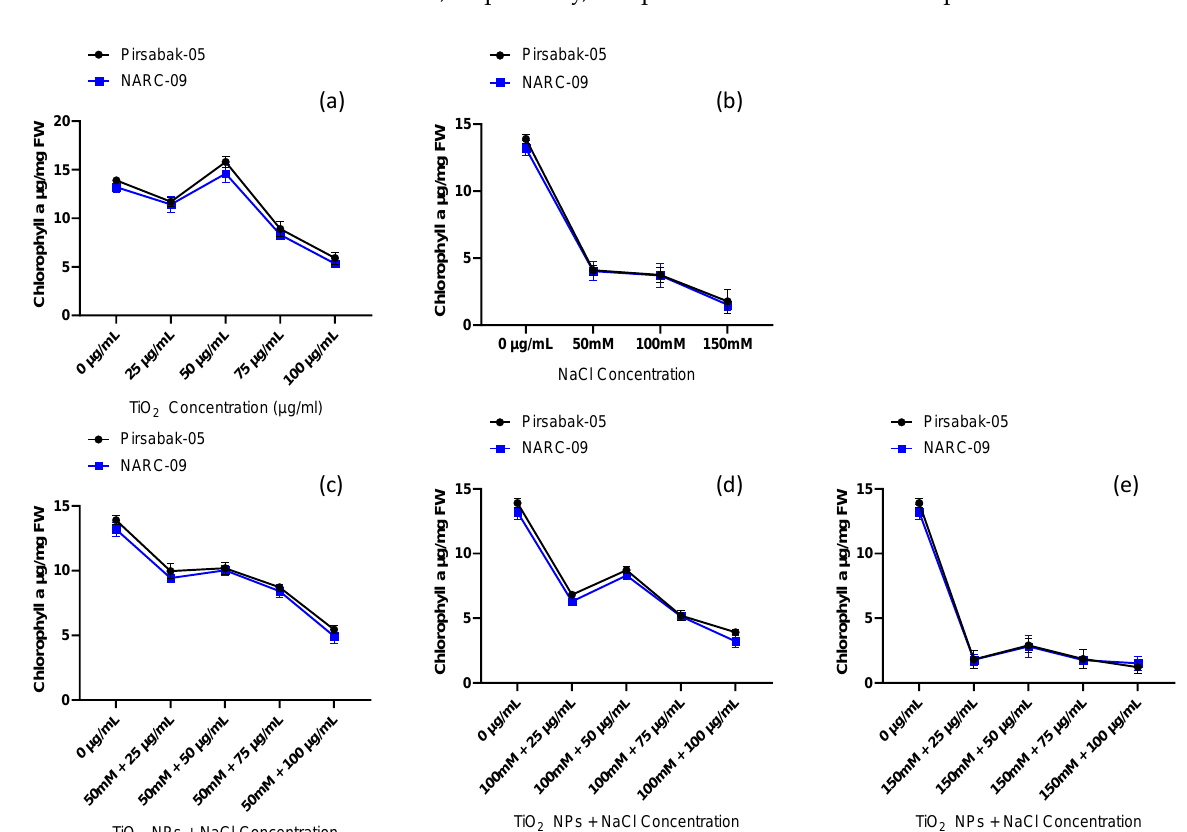
Figure 4. Effects of biogenic TiO 2 NPs on the chlorophyll a. content of selected wheat varieties under salinity stress conditions; ( a ) Effect of different concentrations of biogenic TiO 2 NPs on wheat varieties, ( b ) Effect of different concentrations of NaCl on wheat varieties, ( c – e ) Effect of different concentrations of TiO 2 NPs under varied concentrations (i.e., 50 mM, 100 mM, and 150 mM of NaCl). The data are represented in the form of means, while p was kept at p ≤ 0.05.